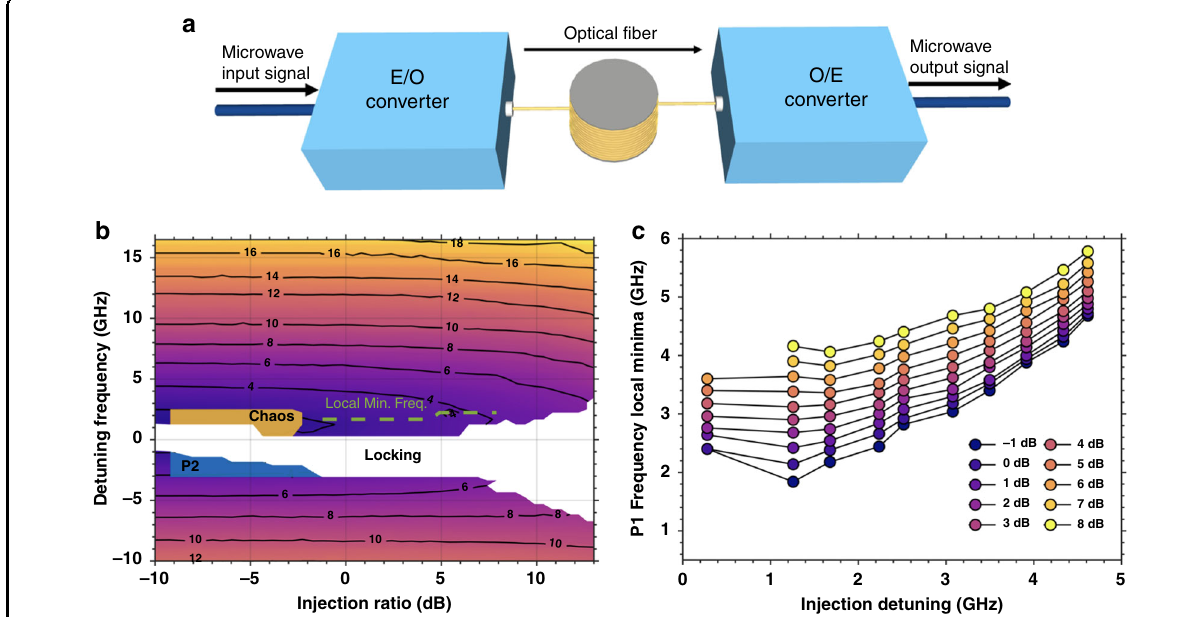
Fig. 5 Photonic microwave generation. ( a ) Schematic of a simple microwave photonic link. ( b ) Measured microwave frequency of the optically injected QD laser. The dashes are points of local minimum frequency. The P2 and chaos regions are also displayed. ( c ) Evolution of the local minimum frequency as a function of the detuning frequency and for different values of injection